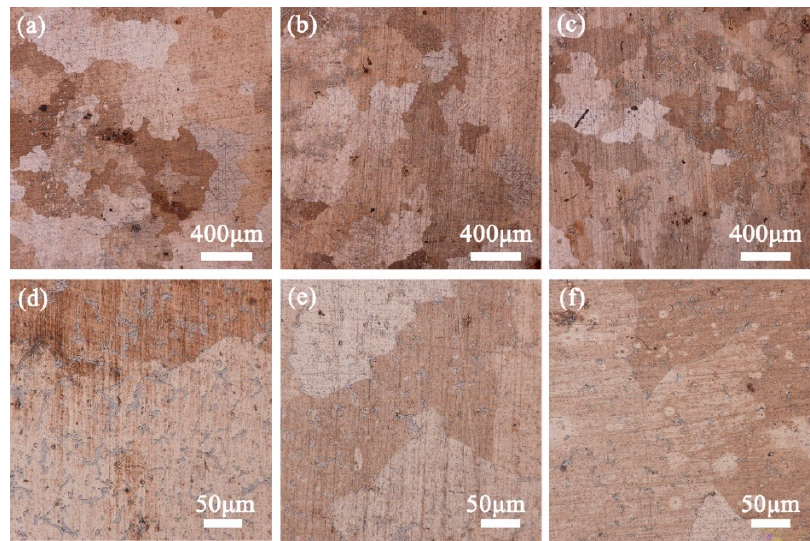
Figure 8. Metallurgical structure of Cu–15Ni–8Sn–xMo alloy after solution at 900 °C for 4 h: ( a , d ) x = 0.3, ( b , e ) x = 0.9, ( c , f ) x = 1.5 wt.%.